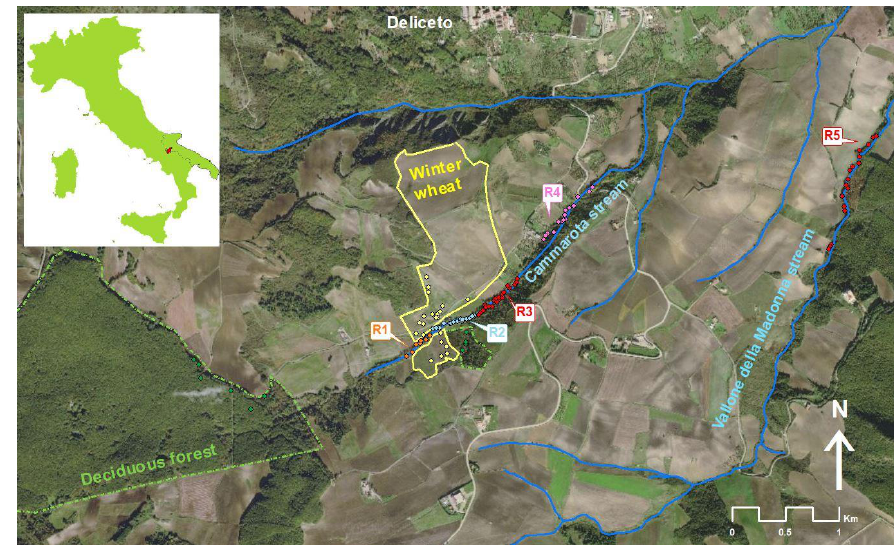
Figure 1. Reaches (R1–R4) of the Cammarota Stream and reach (R5) of the Vallone della Madonna Figure1. Reaches(R1–R4)oftheCammarotaStreamandreach(R5)oftheVallonedellaMadonnaStream. Stream.